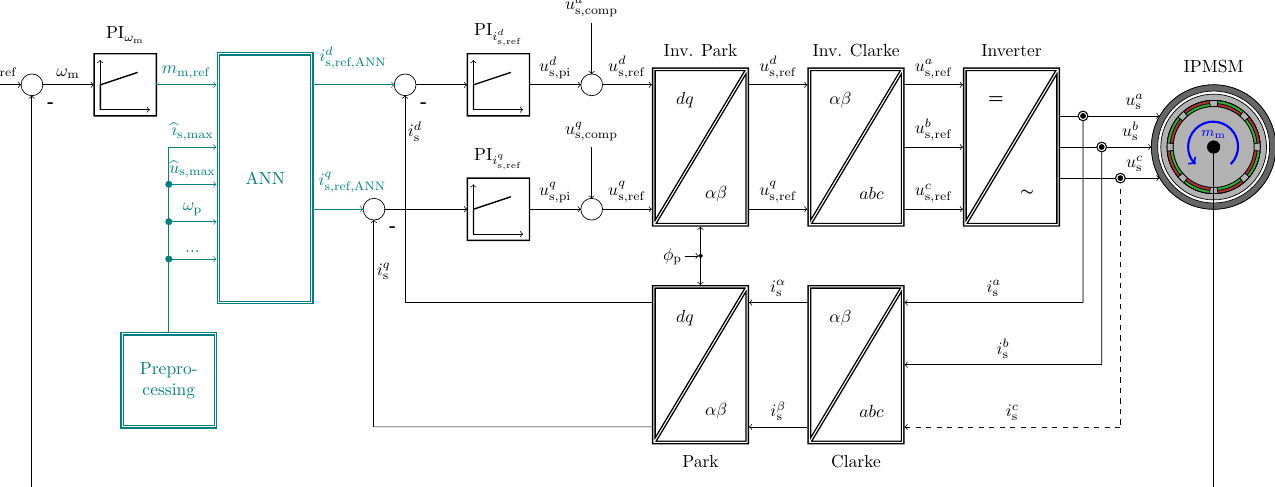
Figure 6. Block diagram of the newly proposed control system with ANN-based OFTC and underlying current controllers of a typical electrical drive system consisting of IPMSM and